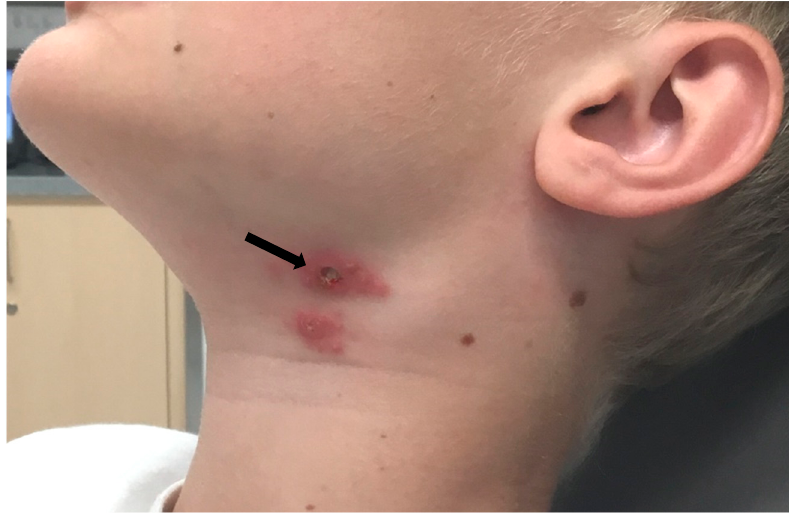
Figure 1. Clinical presentation of ulceroglandular tularemia after tick bite. The ulceration on the site of the tick bite is indicated by an arrow. Lymphadenopathy visible right from the inoculation site. Table 1. Serologic test results of the patient with ulceroglandular tularaemia after the tick bite at the end of June